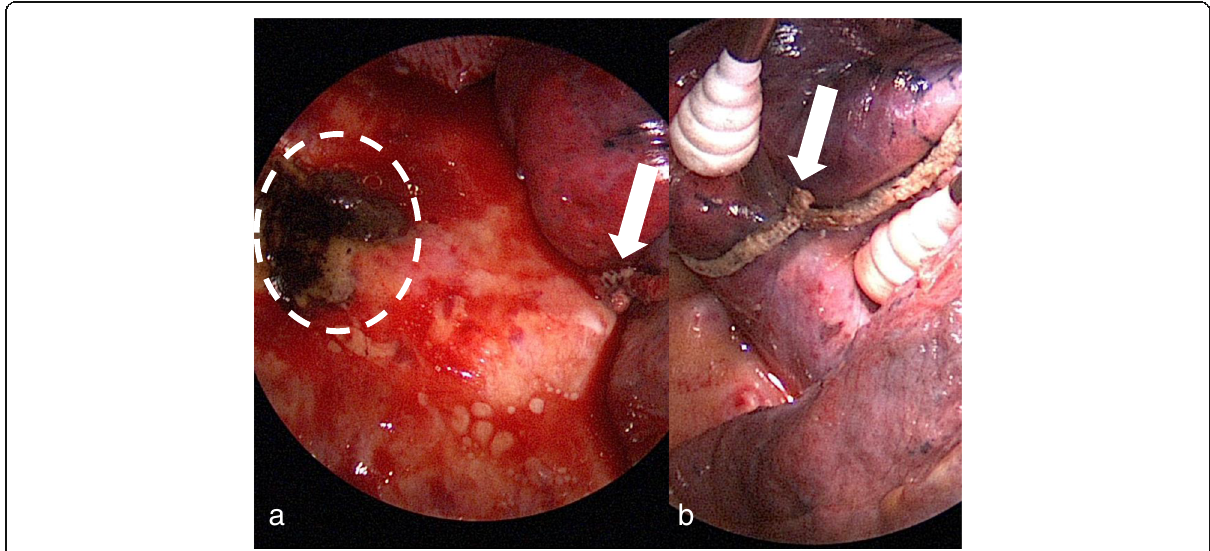
Fig. 3 A surgical view of the reoperation. a Hemostasis of the persistent bleeding from the parietal pleura (dot line) was achieved by electrocautery ablation. b The sharp protruding edge of the staple line (arrow) would have injured the parietal